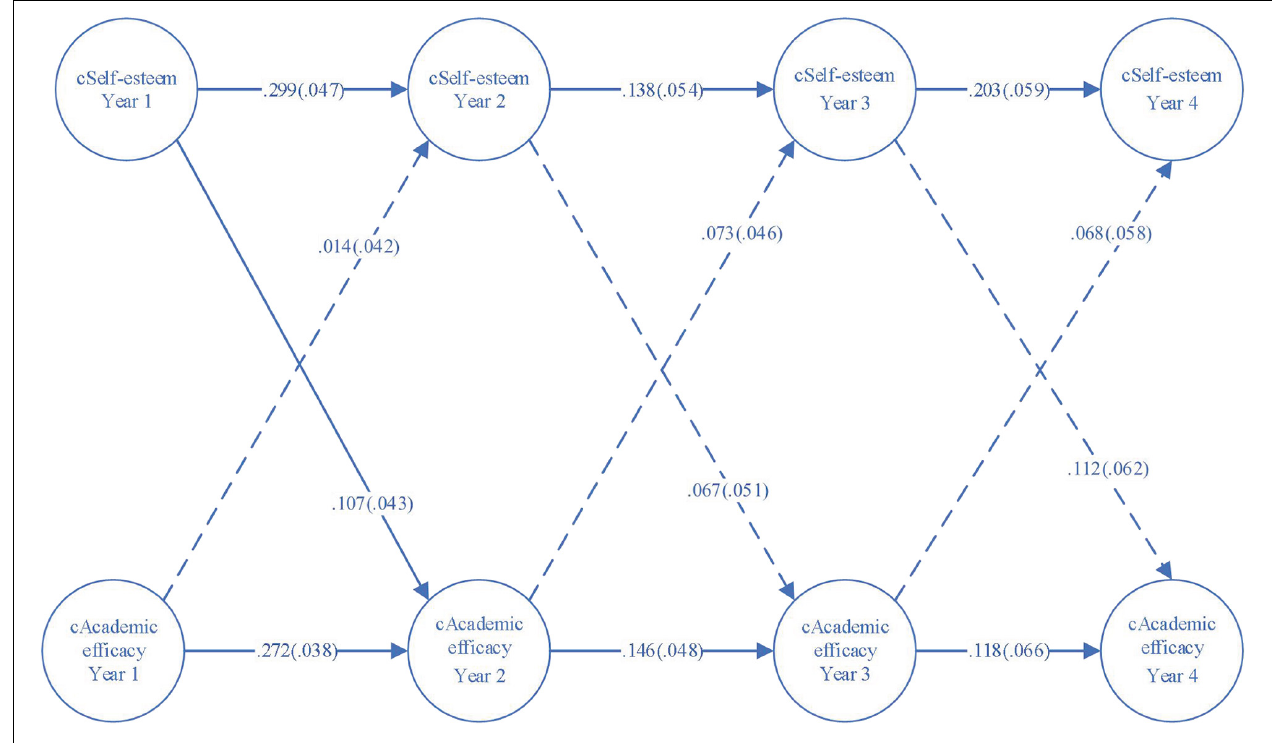
FIGURE 2 | A four-wave cross-lagged panel model with random intercepts (female sub-samples).